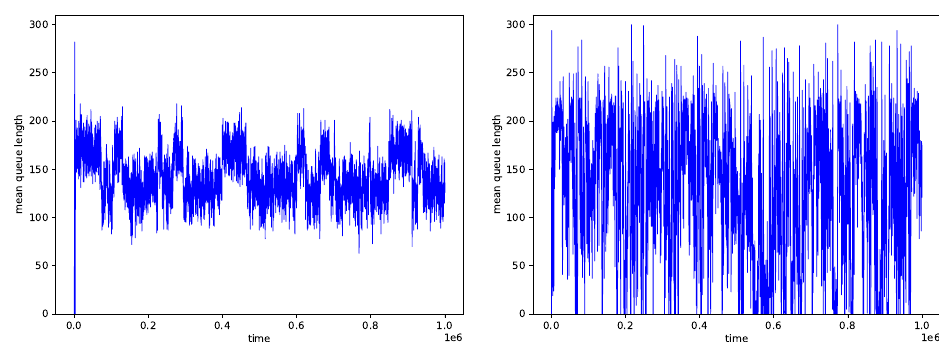
Figure 8. Queue occupancy obtained for CNN controller trained using data regarding three PI α controllers, with CNN History = 500, H = 0.5 ( left ), H = 0.9 ( right ).